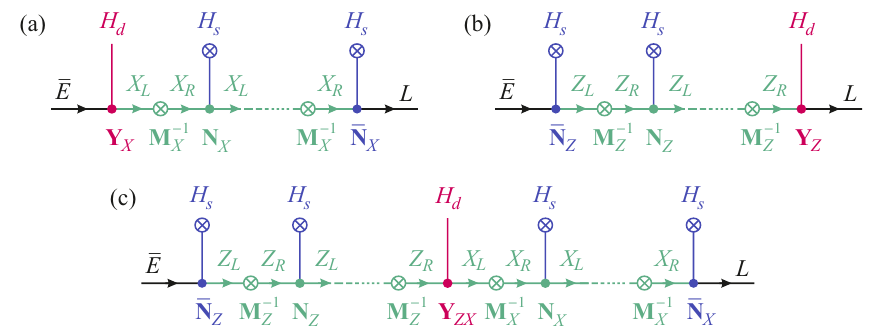
Figure 2 . The e(cid:11)ective contributions to the leptonic Yukawa couplings generated by the tree-level exchanges of (a) a (cid:13)avor-triplet, weak doublet of vector leptons X L;R or (b) a (cid:13)avor-triplet, weak singlet of vector leptons Z L;R . When both these states are present, the two contributions (a) and (b) are accompanied by their simultaneous exchanges